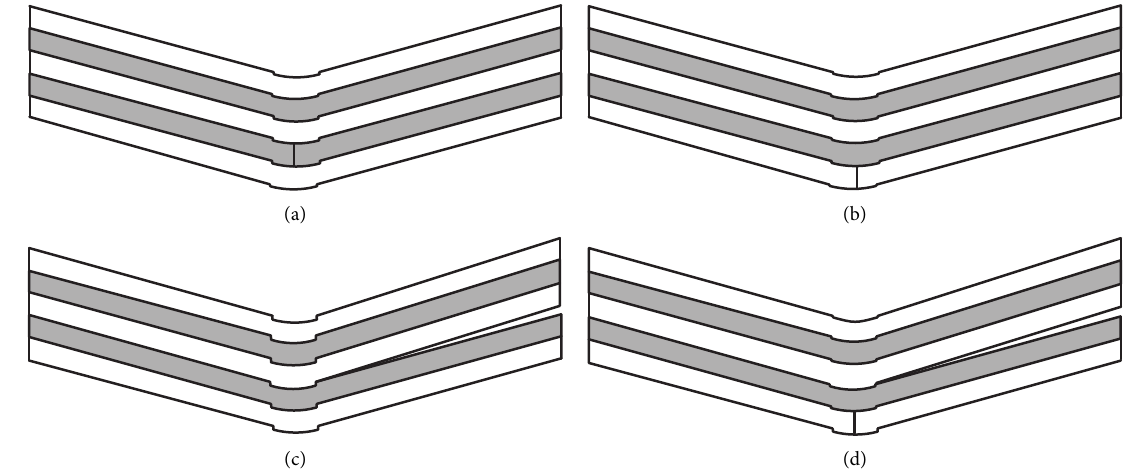
Figure 4: Failure of FML under bending stress [58]. (a) Fiber layer failure; (b) metal layer failure; (c) interlaminar shear failure; (d) mixed